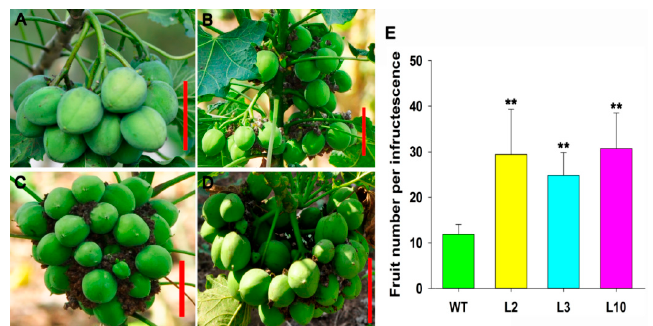
Figure 9. Fruit number per infructescence was increased in the JcDAD1 -RNAi transgenic plants. ( A − D ) Infructescences of the wild type (WT) and transgenic lines L2, L3, and L10, respectively; scale bars = 5.0 cm. ( E ) Comparison of the fruit number per infructescence between the WT and transgenic lines, n ≥ 5. Error bars represent the standard deviations. Student’s t -test was performed to analyze significant differences. ** Extremely significant difference ( p < 0.01).